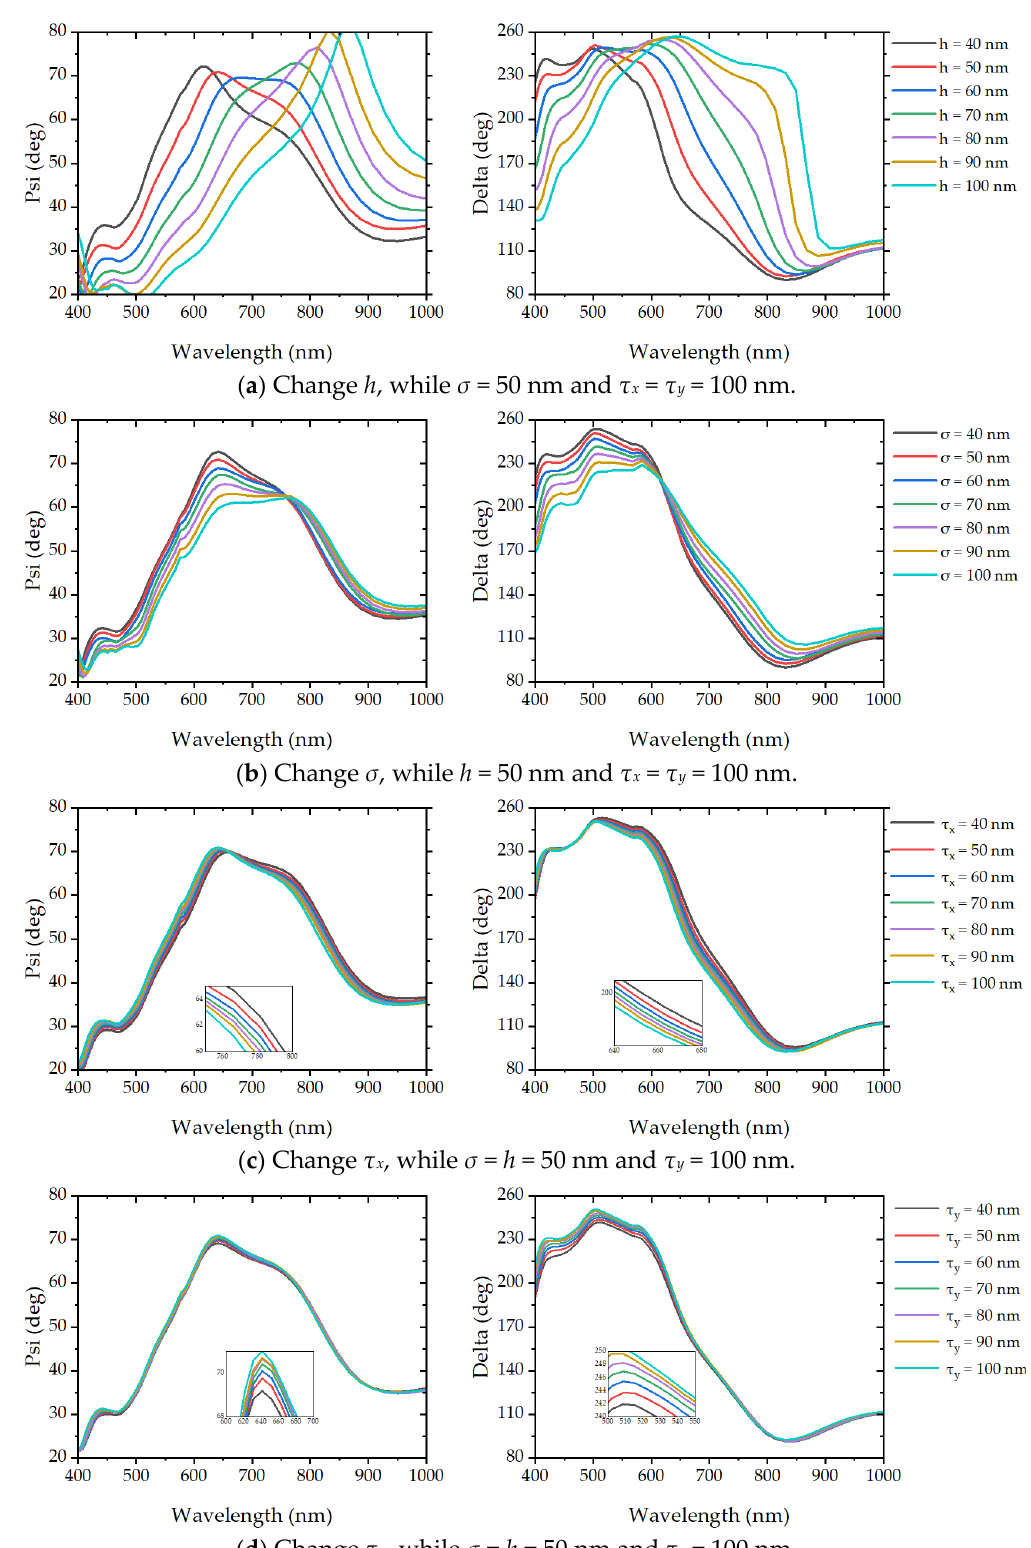
Figure 7. Ellipsometric parameters with different surface topography parameters of the Gaussian random rough surface above the silicon substrate, the SiO 2 film layer with a thickness of 100 nm and the rough layer.